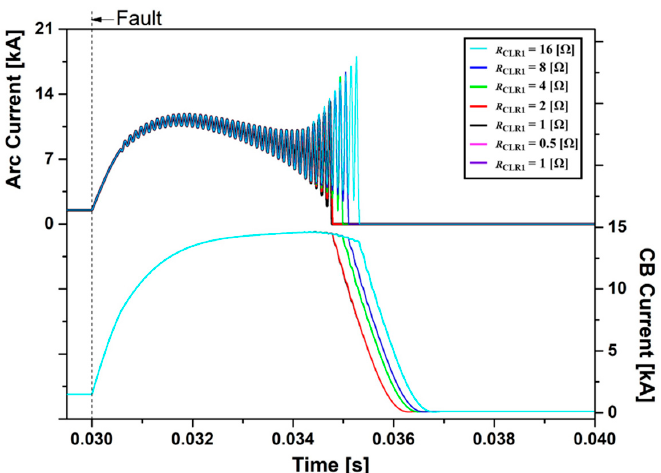
Figure 7. The waveform of DCCB current ( i DCCB ) and arc current ( i arc ) in the case where CLR1 is set to Inductance 3 (mH) and CLR2 is set to Resistance 0, 0.5, 1, 2, 4, 8, 16 ( Ω ).